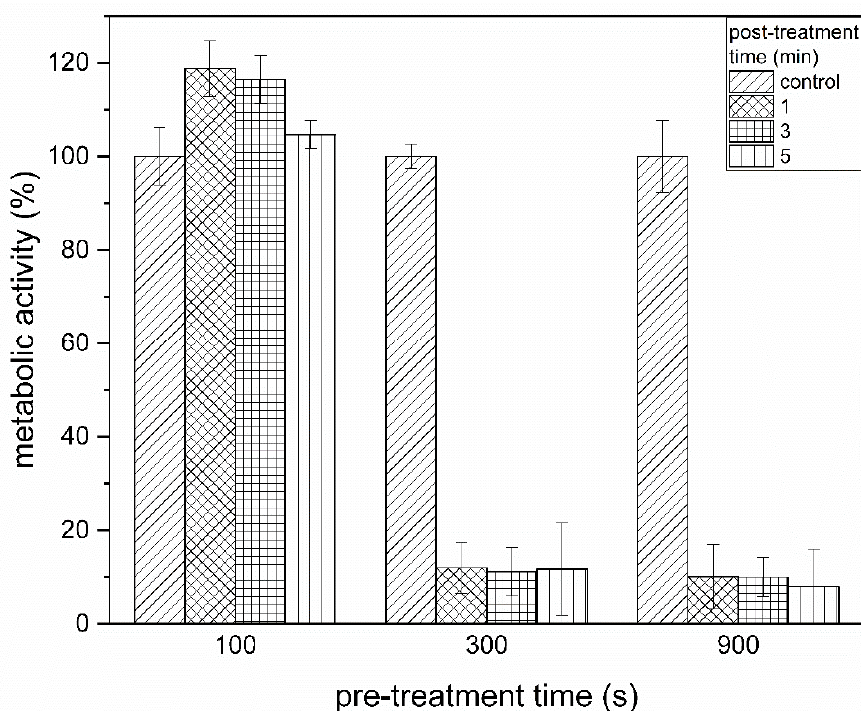
Figure 3. The graph shows the reduction in the metabolic activity of the biofilm cells after treatment of the biofilms with the PTW. The grouped bar chart show at the x-axis the water treatment time with the Midiplexc (pretreatment time) and the di ff erent bars show the biofilm treatment time with the PTW (post-treatment time). The experiment is performed in four independent experiments with three technical replicates each.